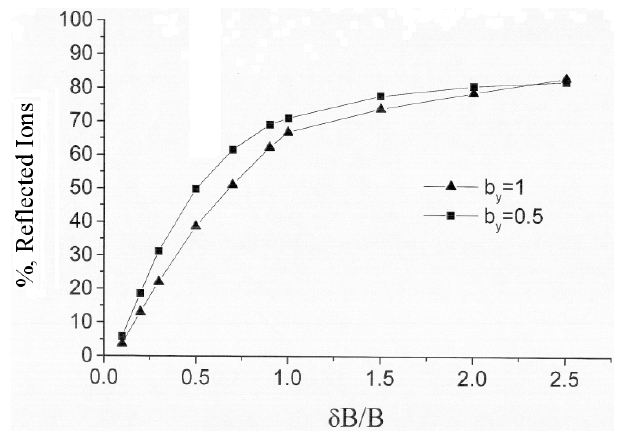
Fig. 8. The same as in Figs. 6, 7 for reflected